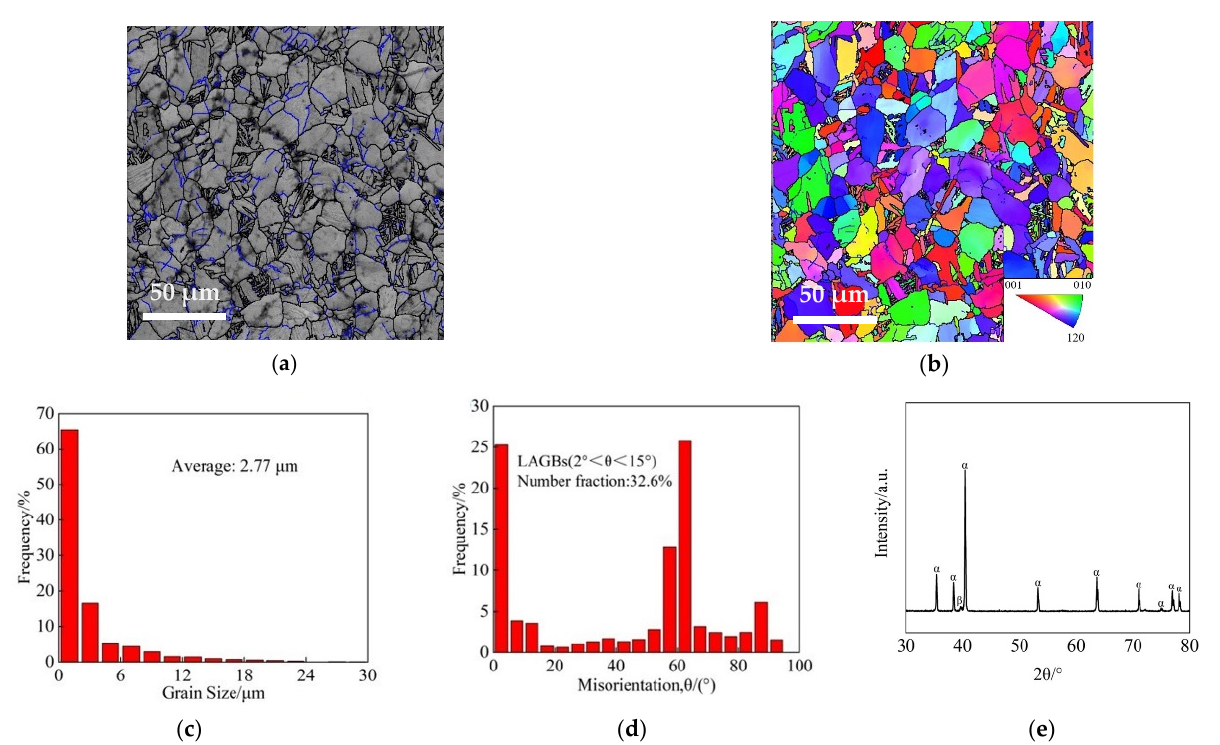
Figure 4. Characterization of initial Ti ‐ 6Al ‐ 4V: ( a ) SEM; ( b ) IPF; ( c ) Grain size distribution; ( d ) Misorientation distribution; and ( e ) XRD.